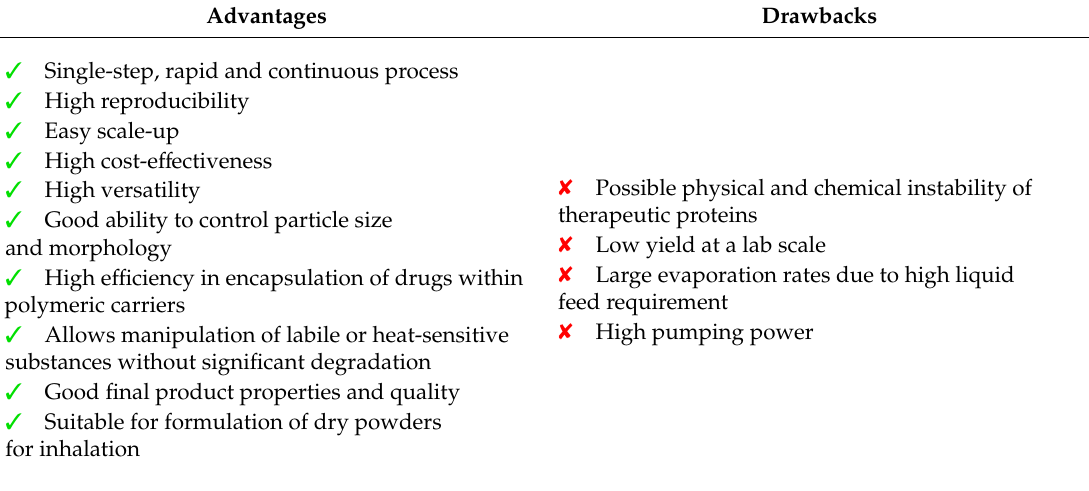
Table 2. Advantages and drawbacks of